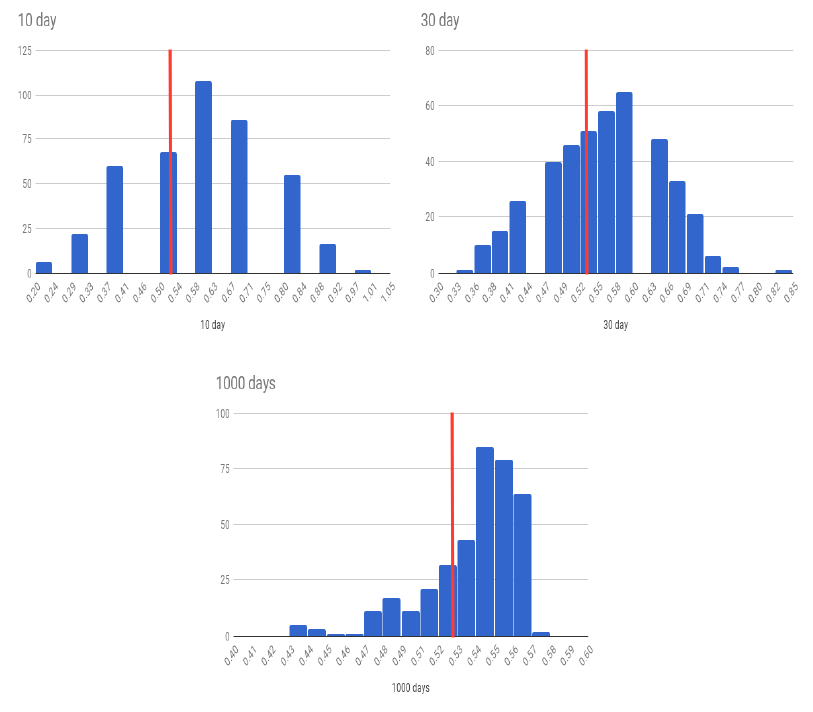
Figure 11. Histograms of the results from all experiments, where the test data was for the Nonstationary out-of-sample experiment (case NS). The three plots are the cases when F = 10, 30, 1000 days, respectively. The red line is at the 52.7% accuracy cut